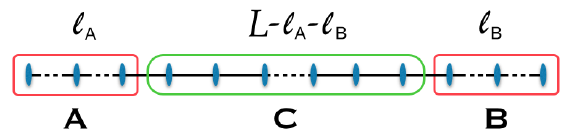
Figure 2: Tripartition of a spin chain into subsystems A, B and C.